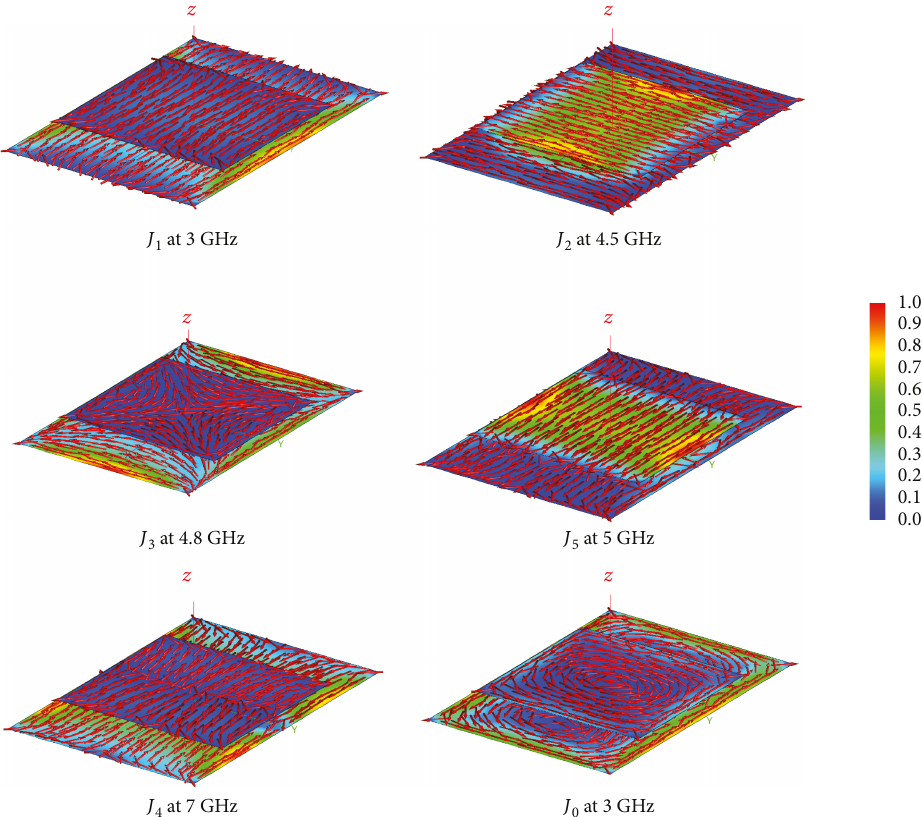
Figure 3: Current distribution of the fi rst six CM of a patch antenna over a rectangular ground plane, near the resonance frequency. Arrows indicate the direction of the current in the ground plane and dashed lines indicate nulls of current.